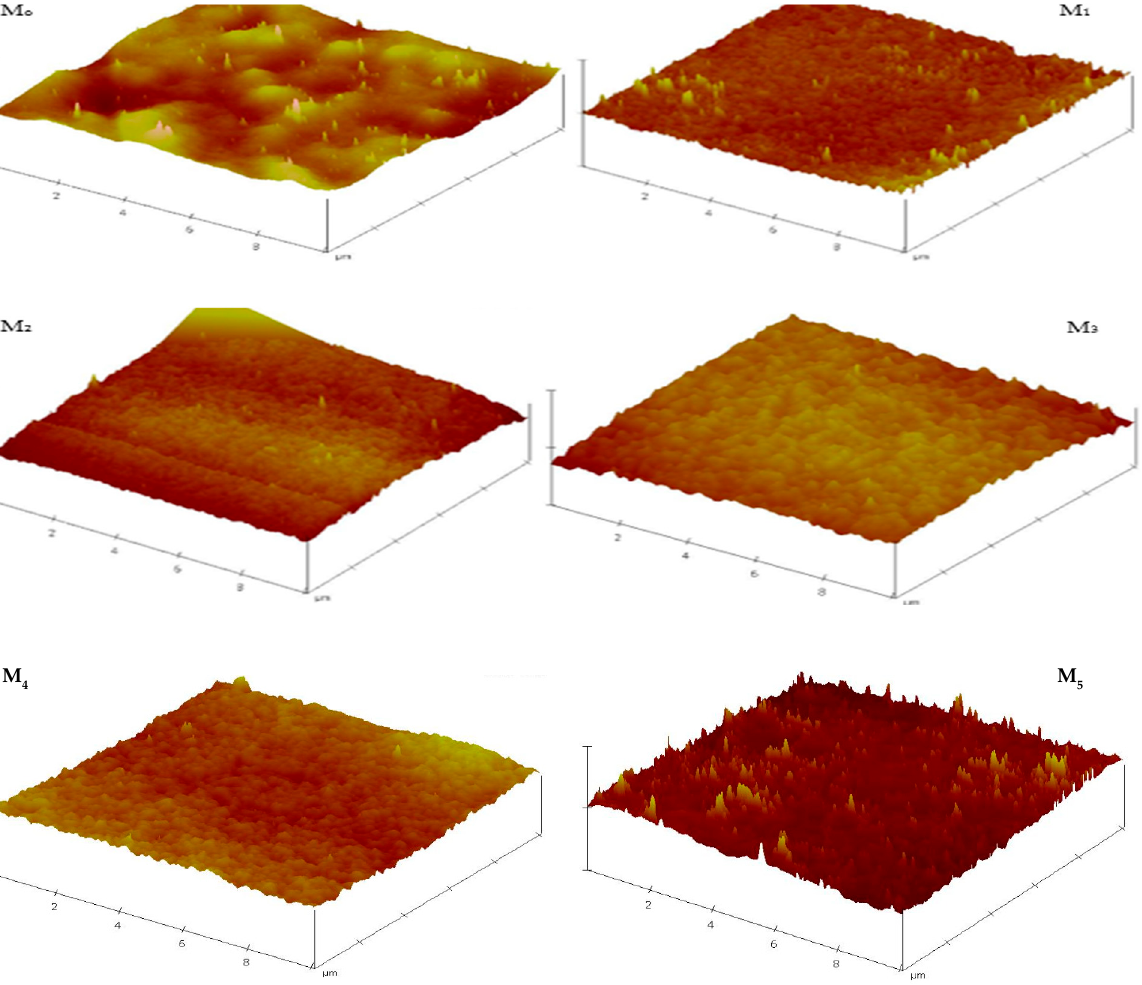
Figure 6. 3D AFM micrographs of composite membranes depicting evolution of surface roughness with PSN content.